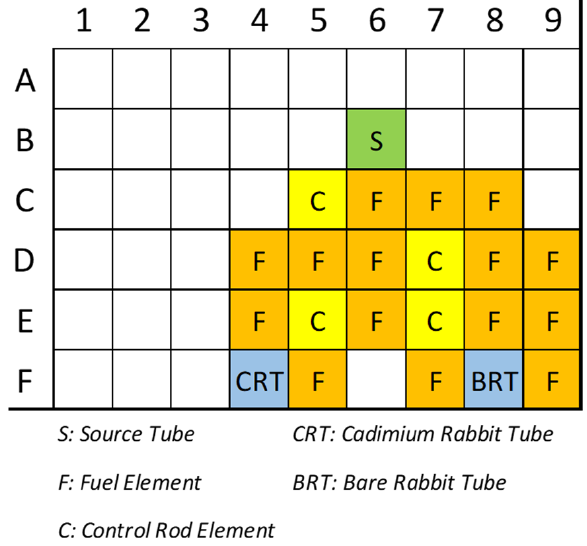
Figure 2. MSTR core configuration (120 W) [12,13].